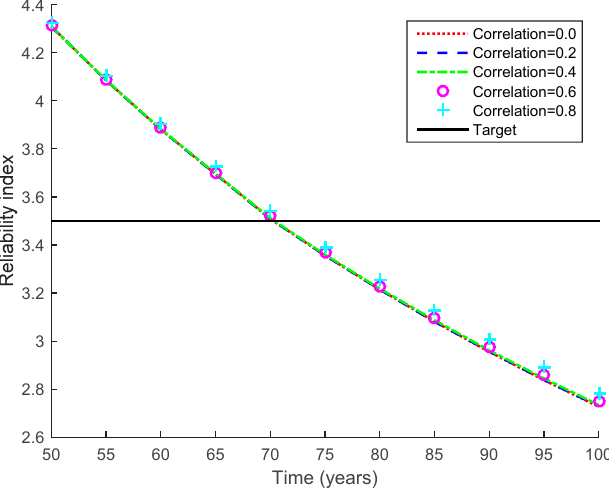
Figure 6. Reliability indices of bridge system with varying correlation coefficients.